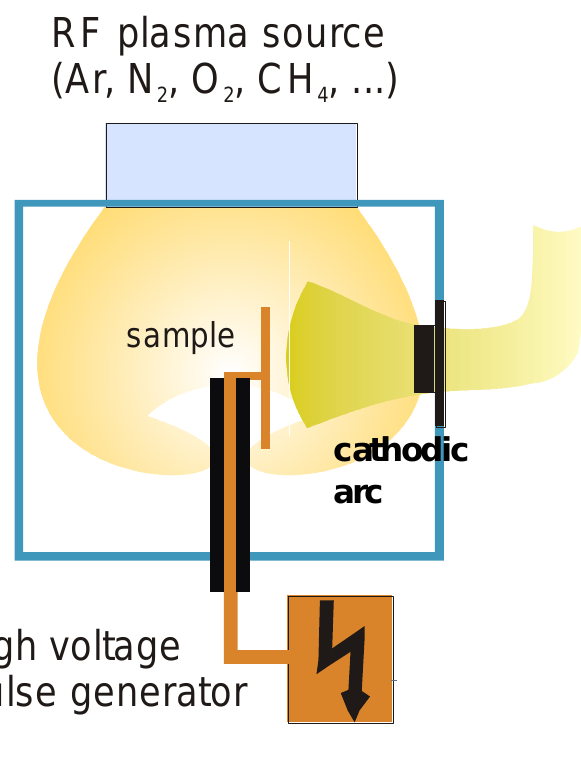
Figure 7 . Presentation of a plasma immersion ion implantation and deposition (PIIID) system with filtered cathodic arc, auxiliary plasma source and high voltage pulse